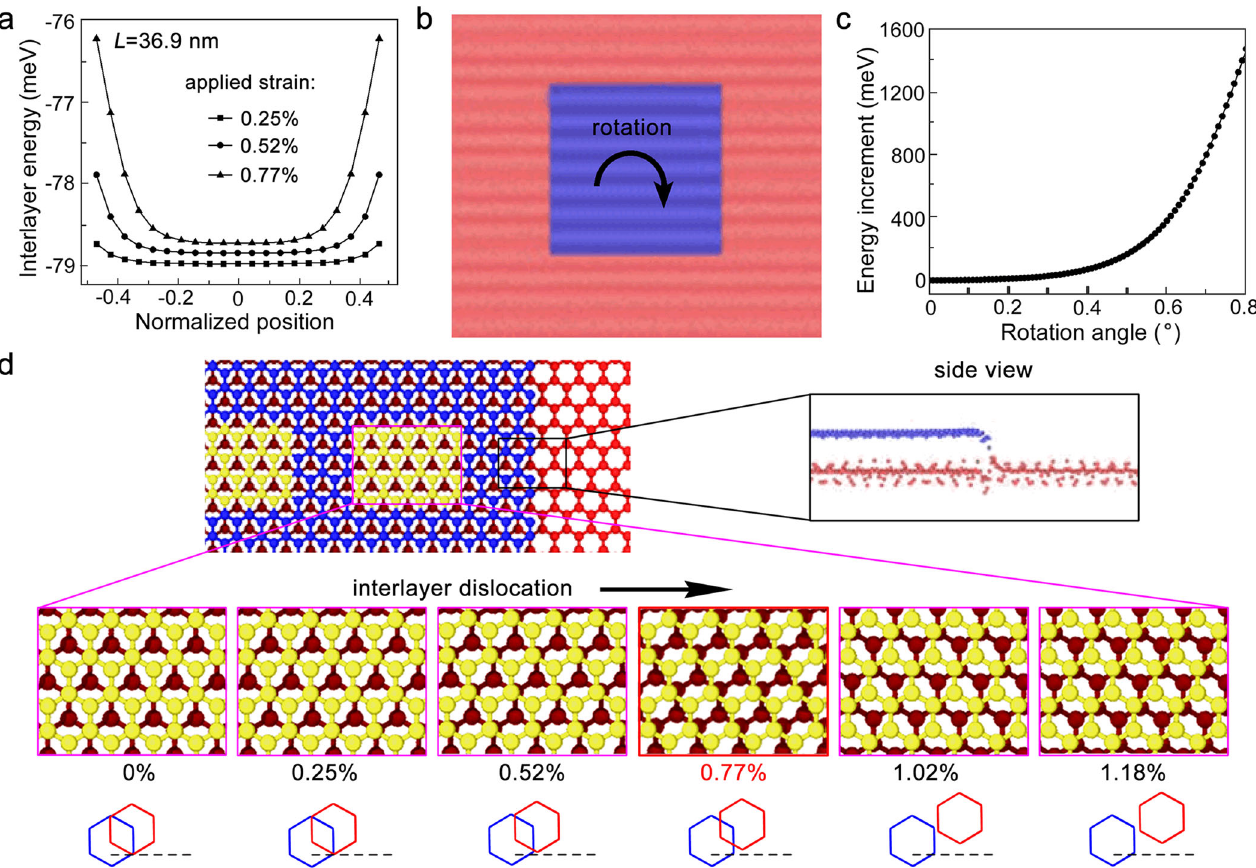
Fig. 4 Variation of the energy and atom con fi guration in the edge of BLG. a Interlayer energy distribution of BLG under different applied strains. b Schematic of simulated rotated BLG. c Energy increment as rotation angle varies in BLG. d Top and side views of the right edge region for simulated BLG and the variation of interlayer dislocation in a top view with increasing strain. The blue and red hexagons represent the top and bottom graphene lattices,